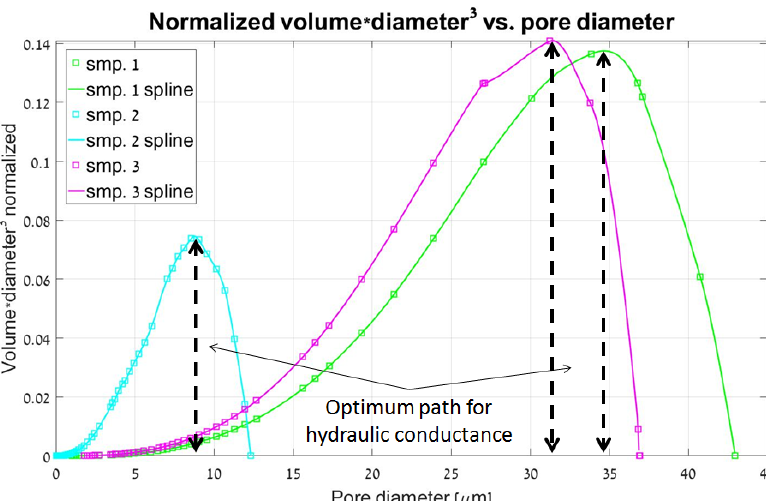
Figure A1. The pore throat length of the maximal hydraulic conductance, l max , is defined from the maximal (normalized) hydraulic con- ductance (Katz and Thompson, 1987), specified at the vertical axis of the chart. The corresponding pore throat diameters ( x axis) marked by black arrows define the pore throat diameters (or pore throat lengths of maximal conductance), l max , where all connected paths composed of l ≥ l max contribute significantly to the hydraulic conductance (see Sect.